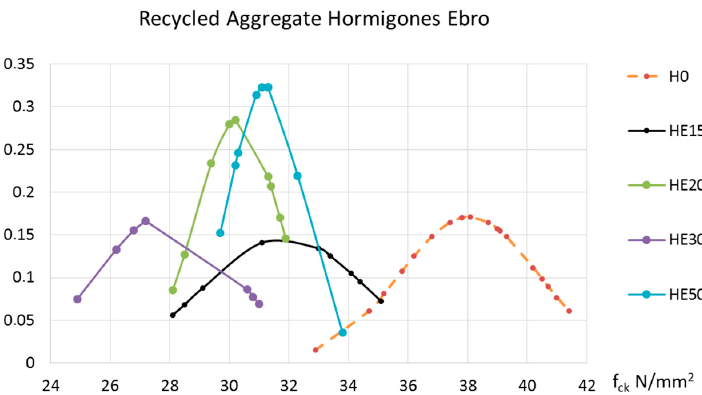
Figure 5. Compressive strength of concrete at an age of 28 days manufactured with recycled aggregates from Hormigones Ebro.